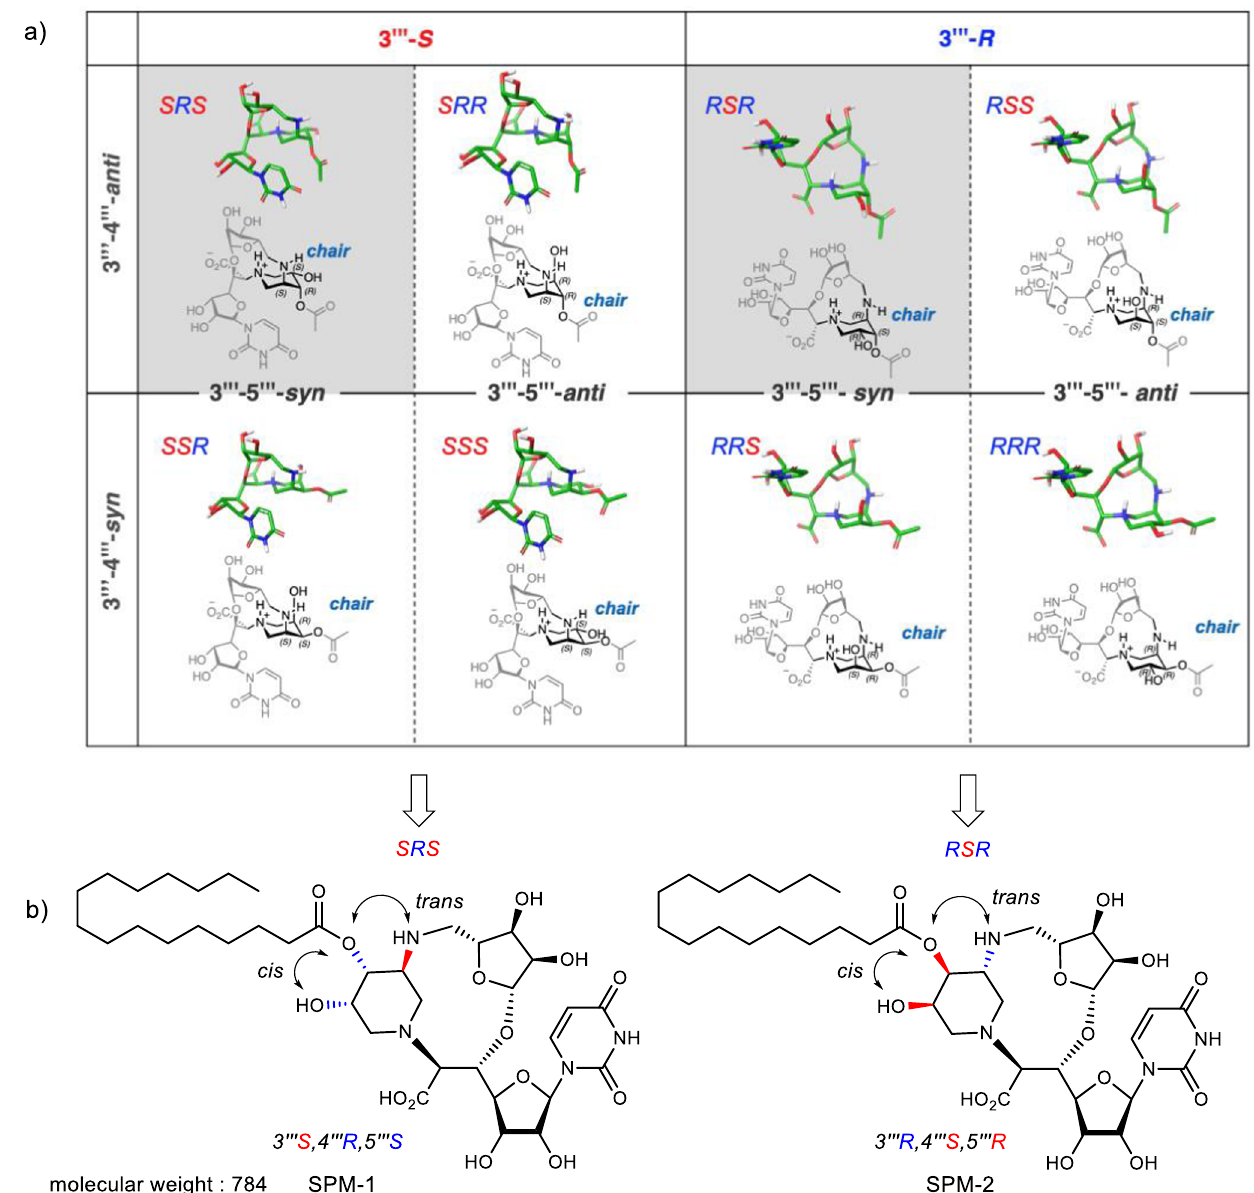
Fig.2|Moleculardesignofsimpli fi edsphaerimicinanaloguesassistedbyconformationanalysis.a ConformationanalysisofthecorestructuresSRS-RRR. b Chemical structures of simpli fi ed sphaerimicin analogues SPM-1 and